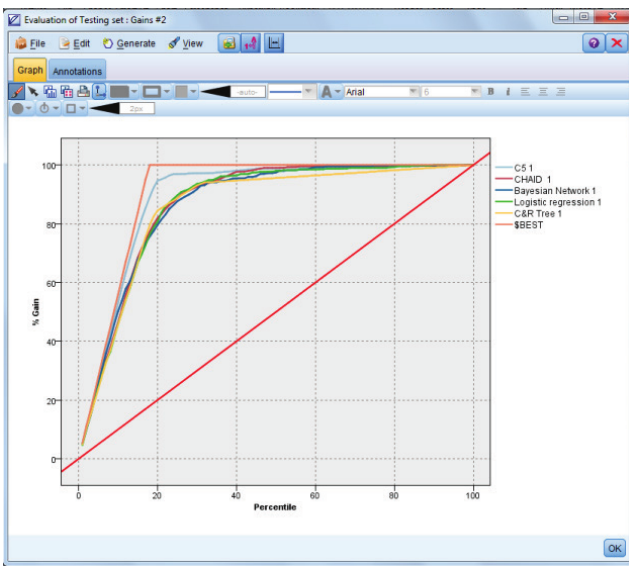
Fig. 5. Evaluation of model characteristics by Gains Chart using IBM SPSS